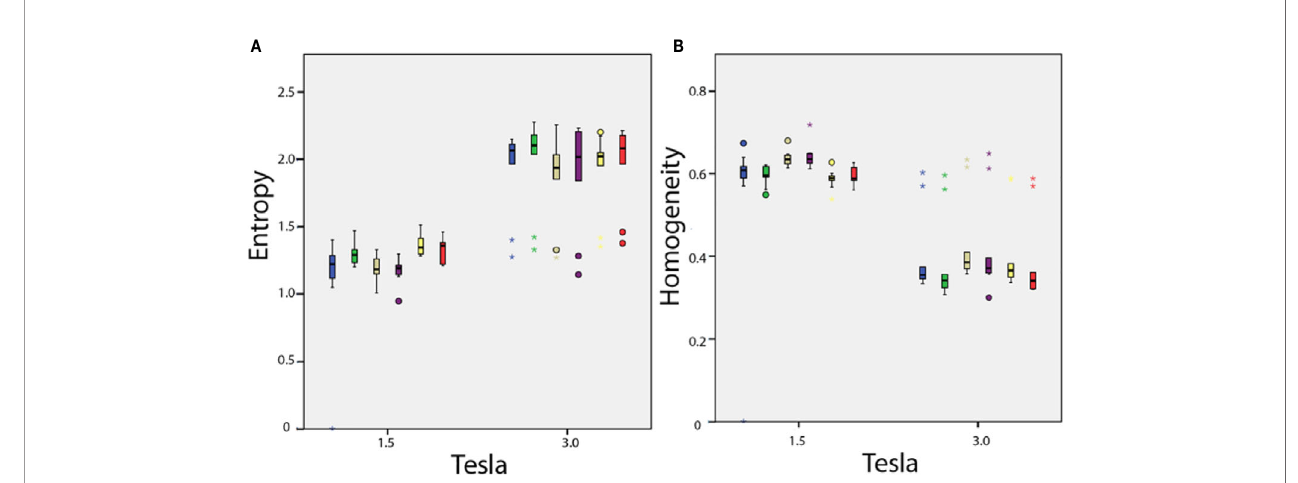
FIGURE 6 | In vivo parameters value difference according to magnetic fi eld strength: (A) entropy and (B) homogeneity. Each box plot represents the values dispersion of the 10 healthy volunteers for one of the six anatomical